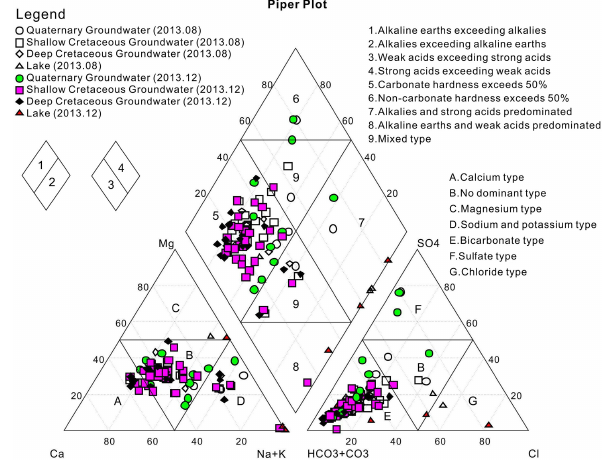
Figure 6. Piper diagram of groundwater and lake water in August and December